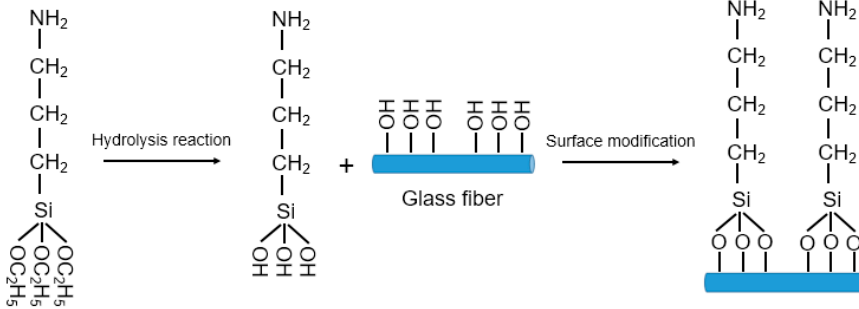
Figure 2. Schematic diagram of the silane coupling agent-modified glass fiber surface.